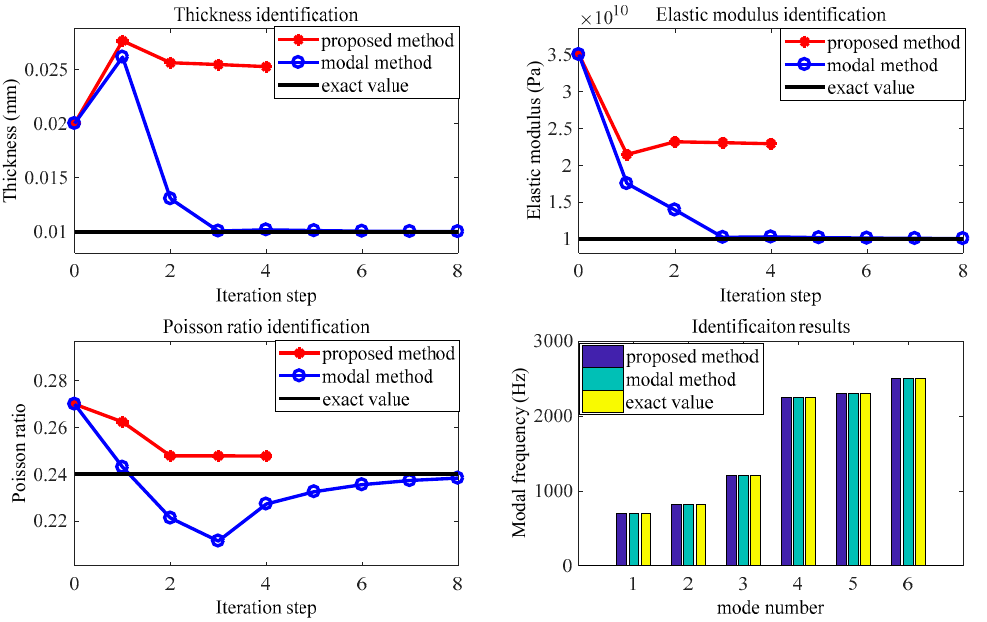
Figure 10. Identification process of the sandwich system.